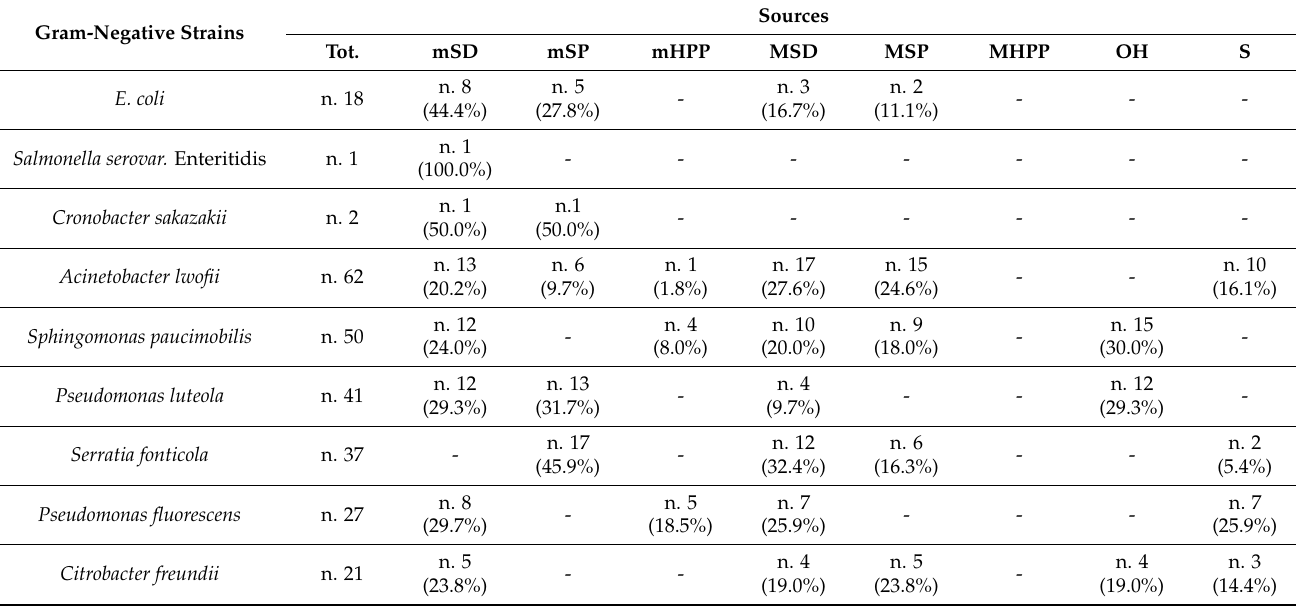
Table 5. Identified Gram-negative strains in this research study.